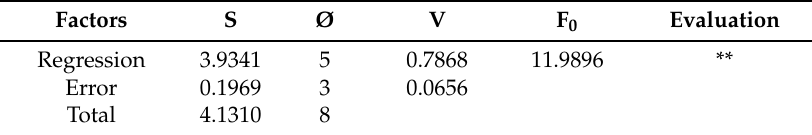
Table 11. Variance analysis for absorption ratio of recycled fine aggregate.